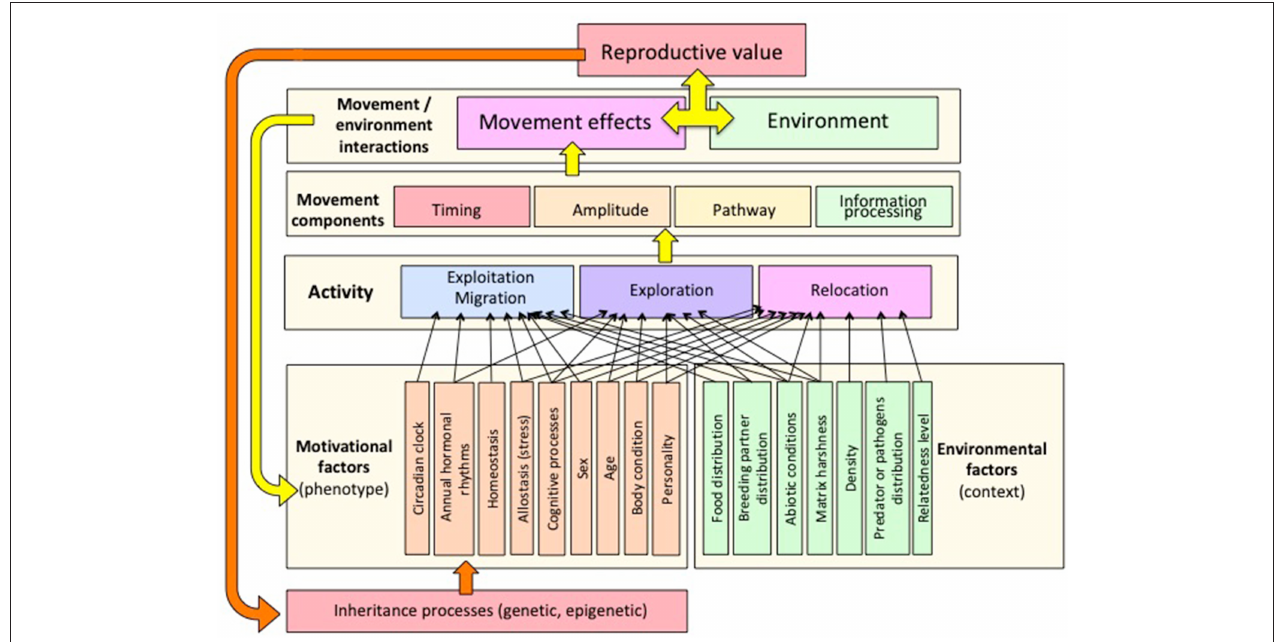
FIGURE 2 | Conceptual framework of movement ecology, organized around a multi-scale typology (exploitation, exploration, and long-distance relocation—see Figure 1 ). A complex interplay between phenotype-dependent variables and environmental variables (context-dependence) determines activity type and movement characteristics. Movement is characterized through four basic components [timing, distance amplitude (spatial scale), pathway (speed and sinuosity), and information processing (orientation mechanisms)]. The yellow arrow expresses plasticity feedback at the scale of the individual, including learning processes. The orange arrow expresses the evolutionary feedback at an intergenerational scale based on selection or on epigenetic processes.